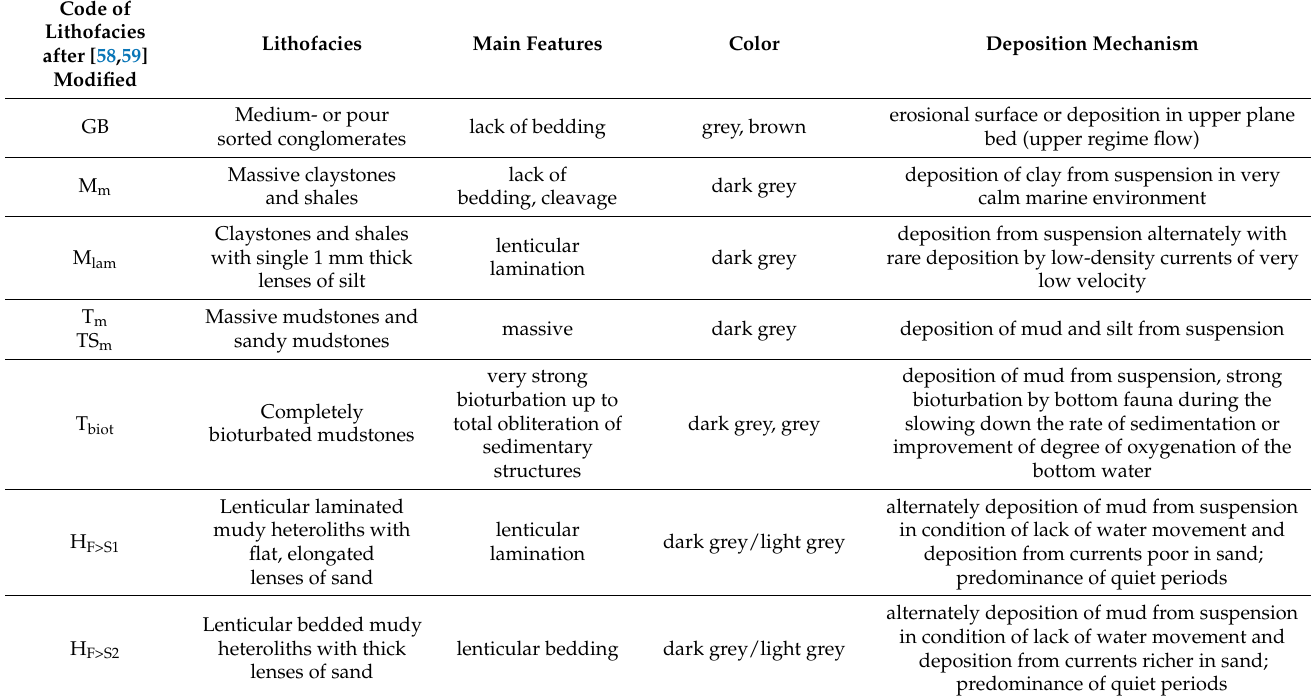
Table 1. Characteristics of the lithofacies present in the investigated